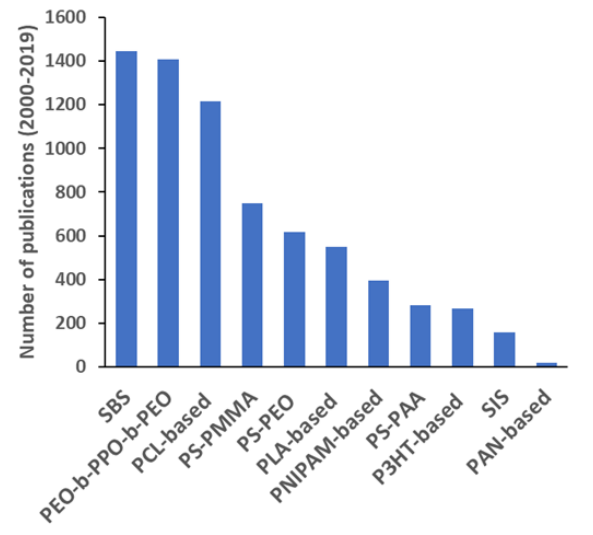
Figure 11. Number of publications related to representative block copolymers from 2000 to 2019.